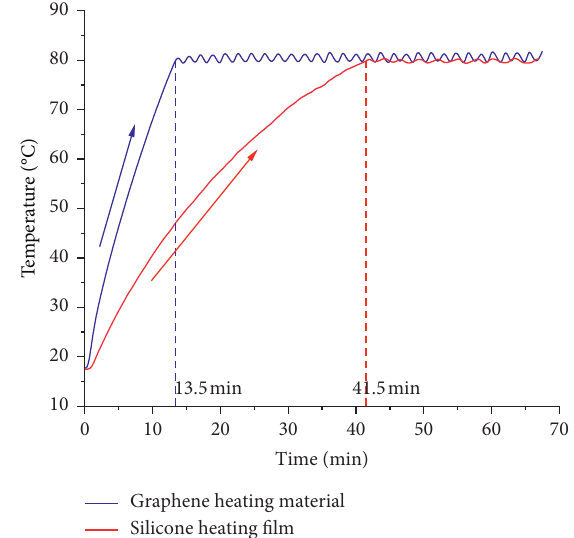
Figure 6: Water warming experiments with two different heating